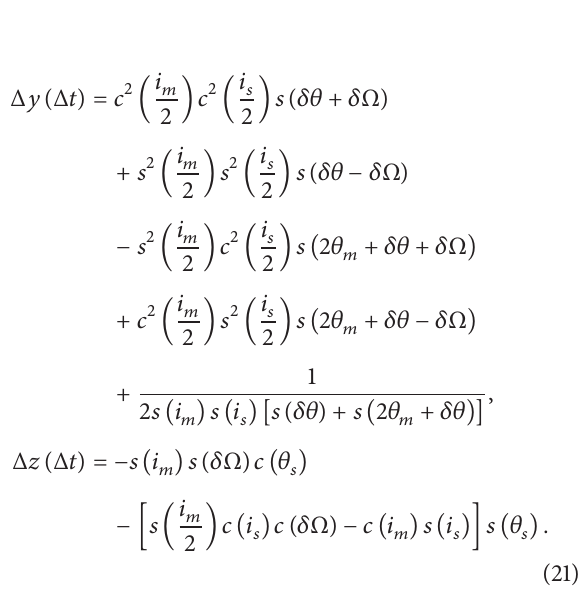
Figure 6: Deviation in